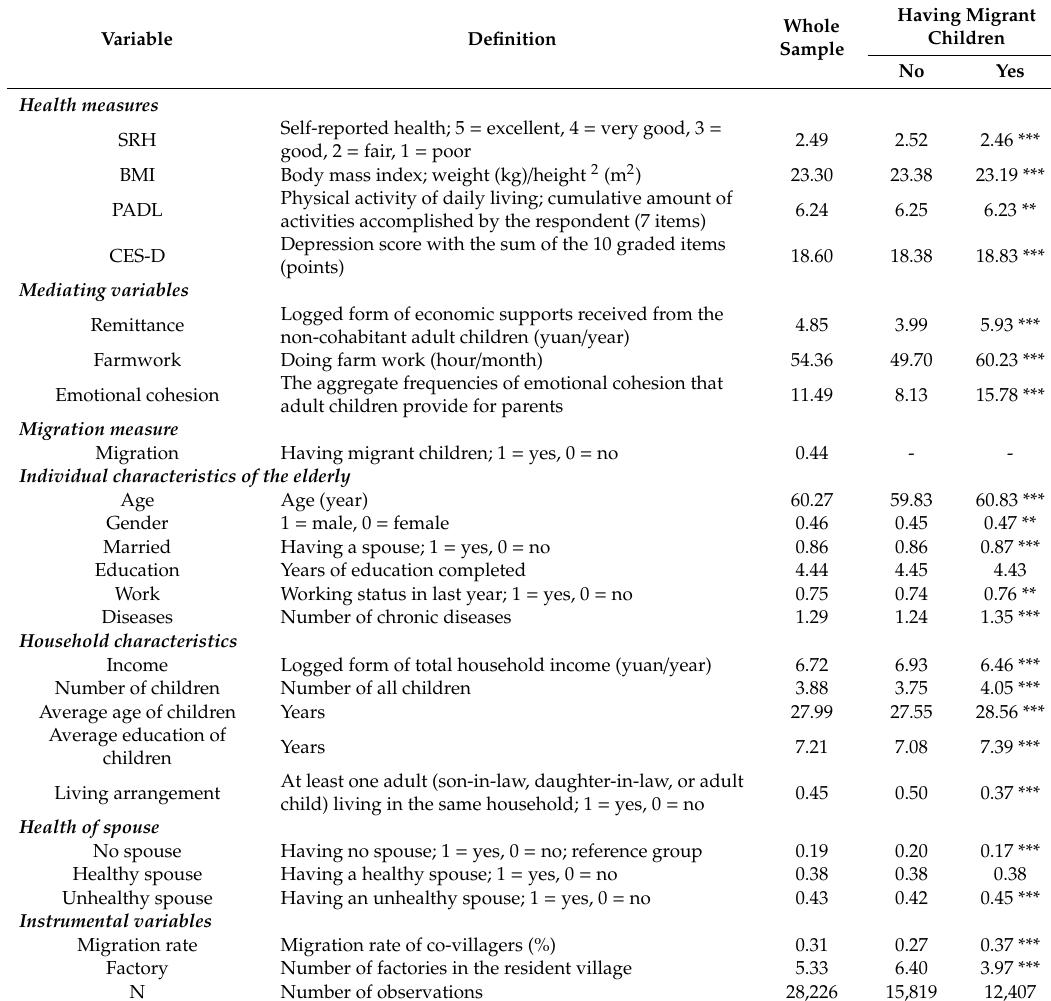
Table 1. Average values for the variables